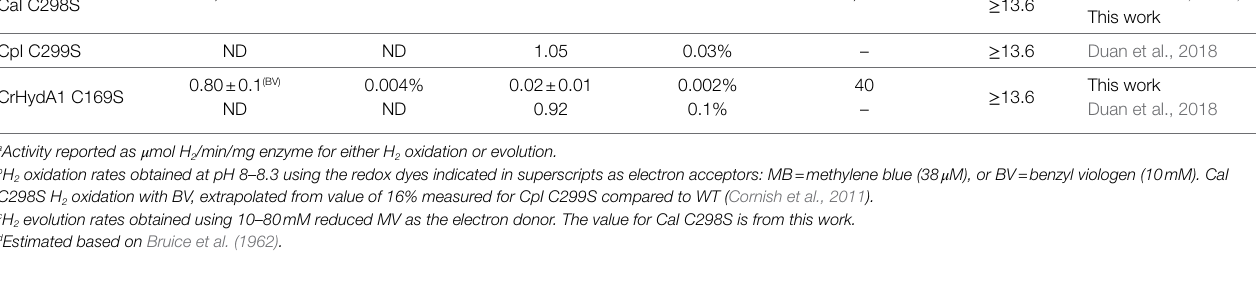
TABLE 3 | Activity a profiles of [FeFe]-hydrogenase C → D variants. Enzyme